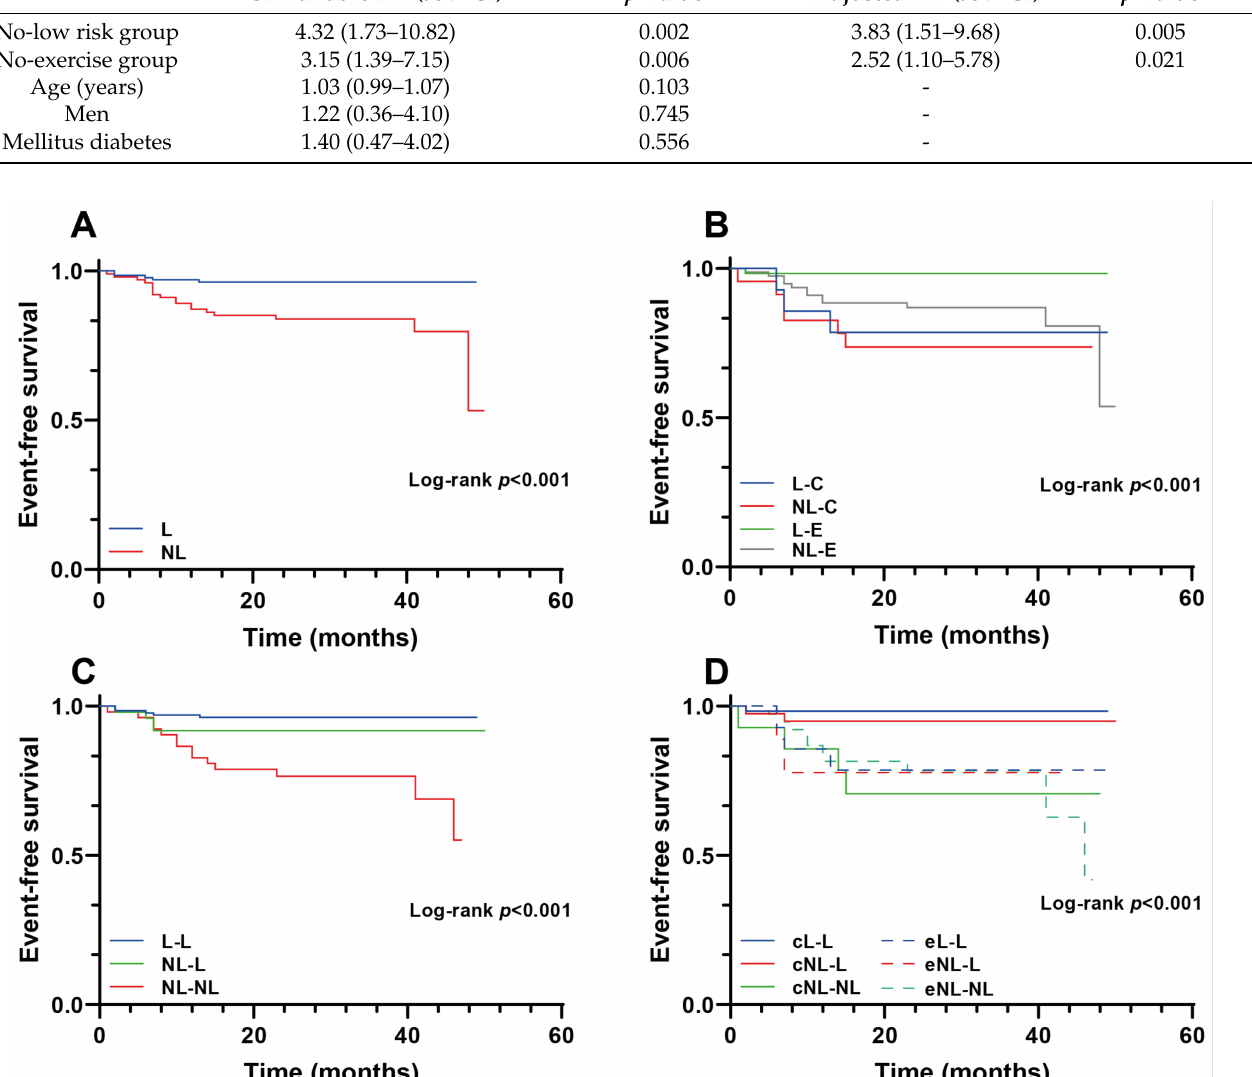
Figure 1. Kaplan–Meier curves according to the different risk groups. Panel ( A ): Global risk strat- ification. Panel ( B ): Exercise compliance classification. Panel ( C ): Rehabilitation risk stratification variation. Panel ( D ): Rehabilitation exercise compliance risk stratification variation. L, Low-risk group; NL, No-low risk group; C, Control; E, exercise; L-L, low to low risk; NL-L, No-low to low risk; NL-NL, No-low to no-low